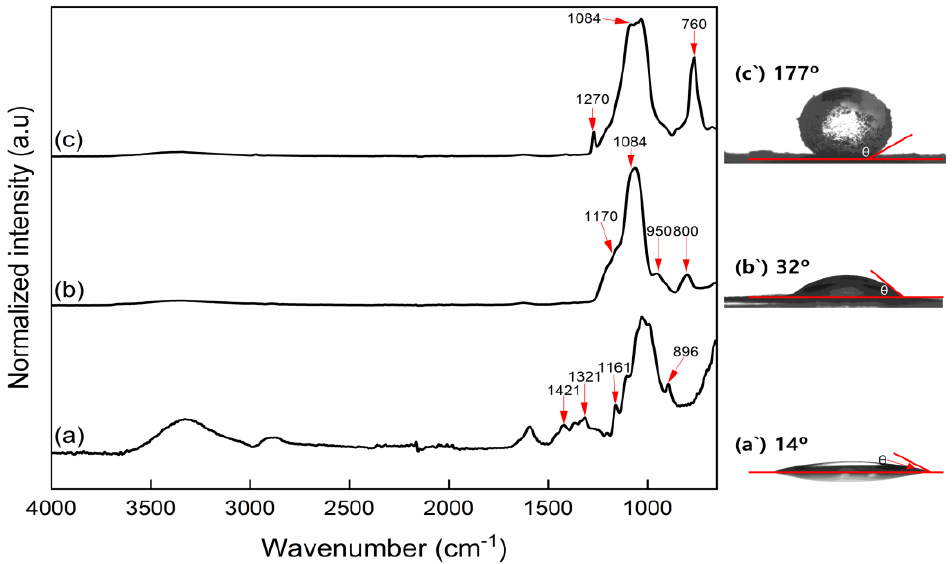
Figure 5. FT-IR peak and water contact angle of the ( a , a’ ) Non-treat CNFs; ( b , b’ ) TCNFs; ( c , c’ ) TMCNFs.